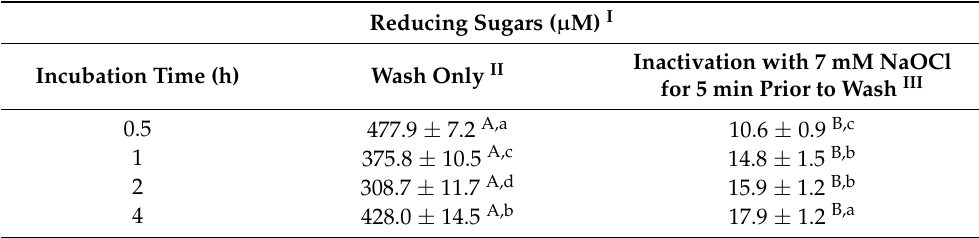
Table 4. I Reducing sugar concentration ( µ M) of 15% raw potato starch treated with 11 µ g mL − 1 (~190 nM) Bl - α Amy for 0.5–4 h. II samples inactivated by multistep washing only. III samples inactivated by NaOCl (7 mM) before the washing procedure. Different superscript letters A,B and a–d in each row and column, respectively, indicate significantly different reducing sugar concentrations